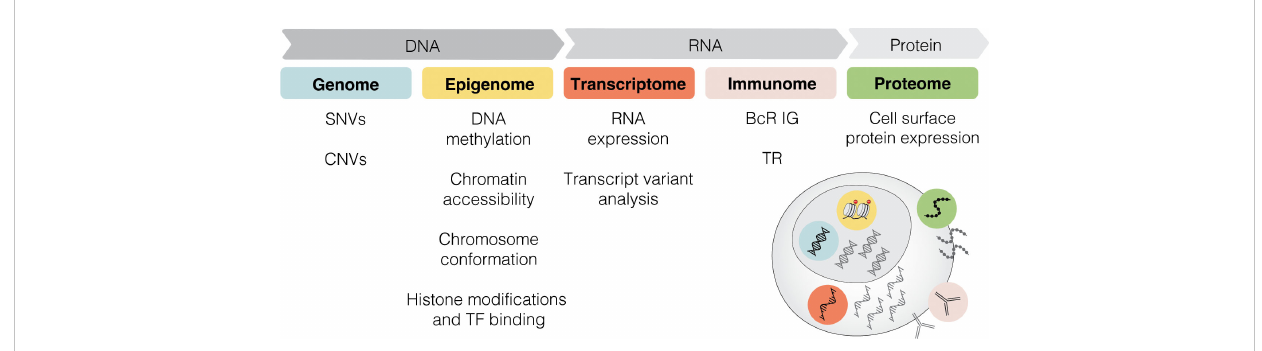
FIGURE 3 Multi-modal pro fi ling. SCS methods can detect alterations across multiple modalities, including genome, epigenome, transcriptome, immunome, and proteome. SNV, single nucleotide variant; CNV, copy-number variant; TF, transcription factor; BcR IG, B cell receptor immunoglobulin; TR, T cell